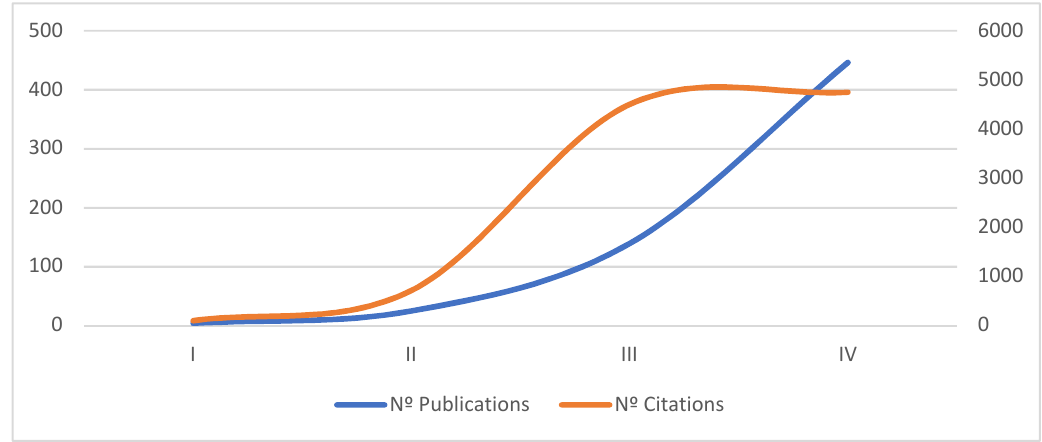
Figure 2. Evolution of number of publications and citations by period.